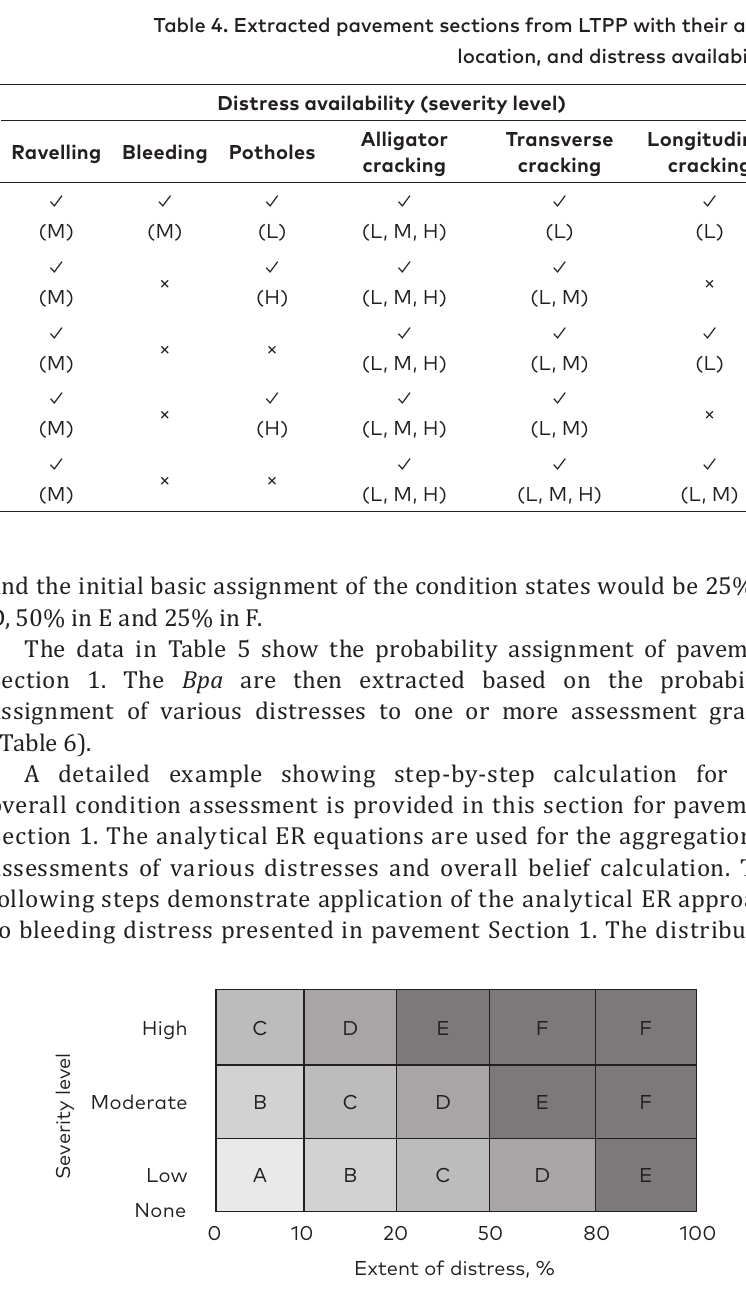
Figure 1. Pavement condition matrix based on distress severity level and extent (Abu Dabous et al.